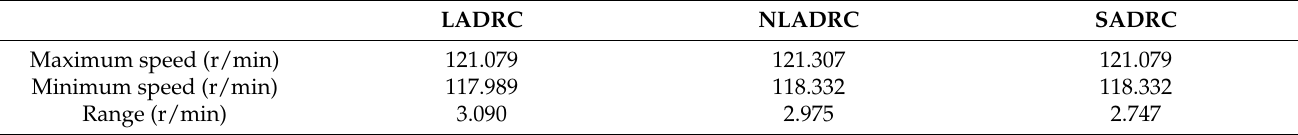
Figure 10. Speed waveforms at steady-state for the three control strategies: ( a ) LADRC ( b ) NLADRC ( c ) SADRC. Table 3. Performance comparison of steady-state